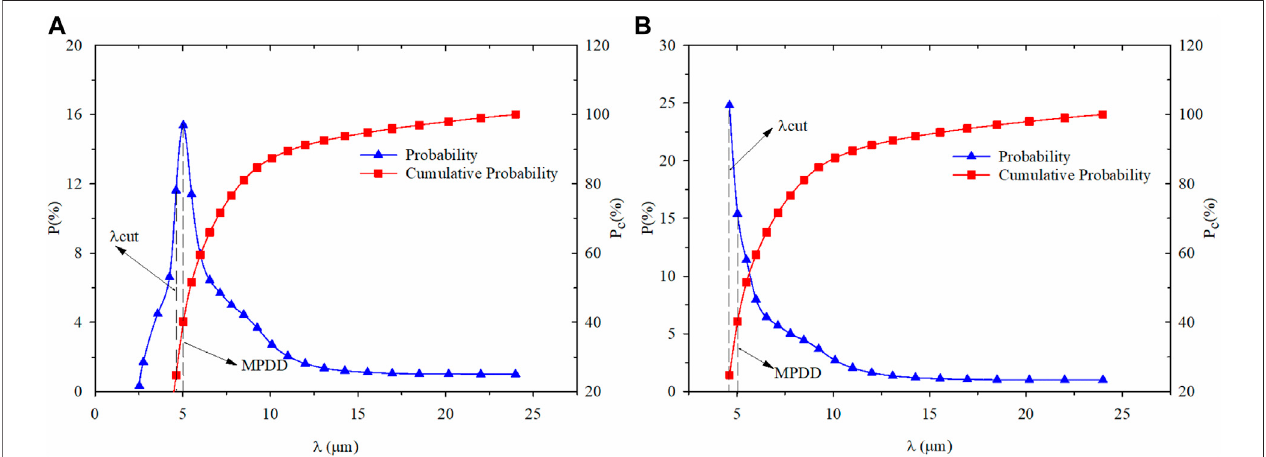
FIGURE 1 | The microsphere size distribution is based on dynamic scattering. (A) Initial state microsphere size distribution; (B) Microsphere size distribution after number accumulating at cut value.